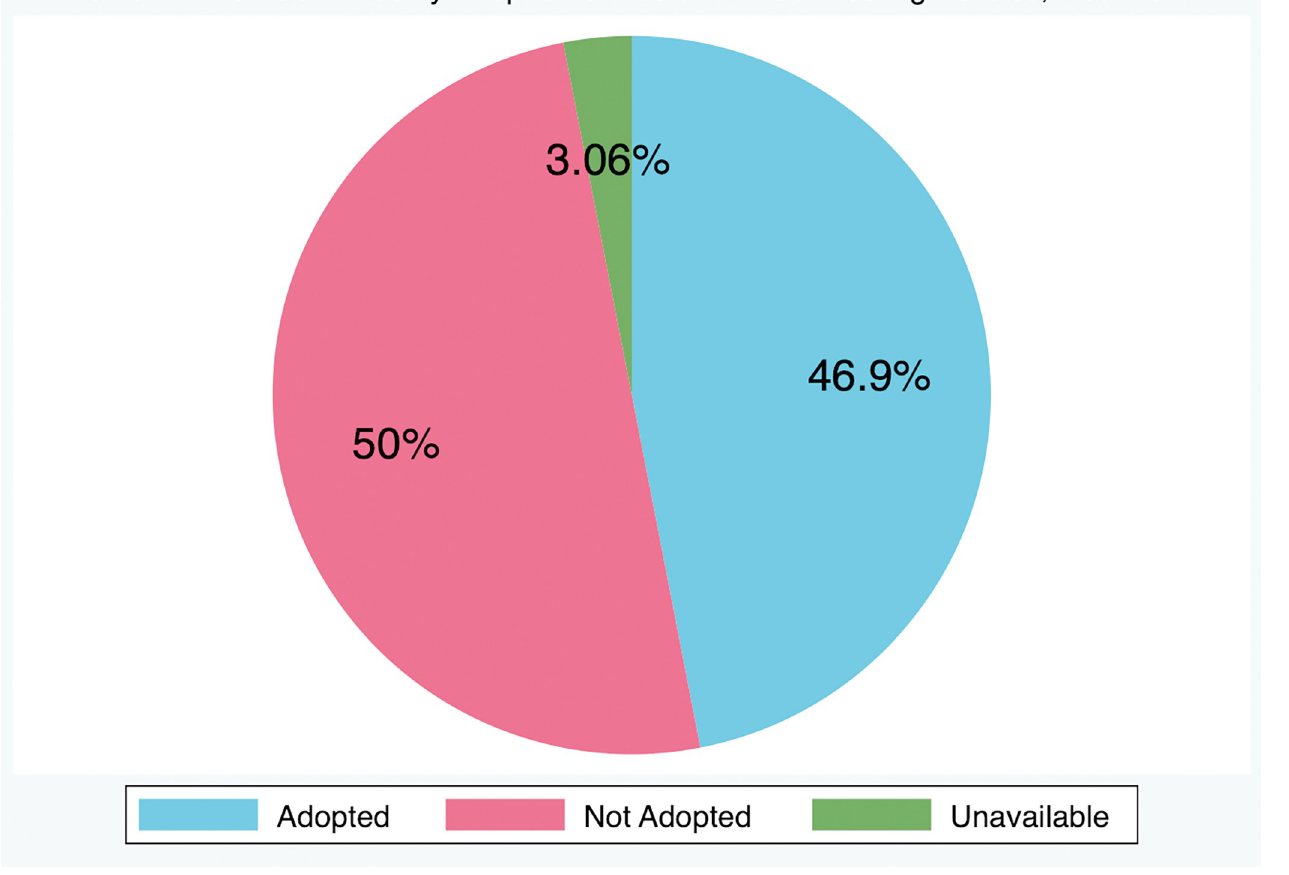
Fig 1. Percent of 194 countries by adoption status of HIV self testing policies, Dec. 2021. 46.9% of 194 countries have adopted policies authorizing HIV Self-Testing in-country, 50.0% have not adopted, and information is unavailable for 3.1% of countries, as of December 2021.